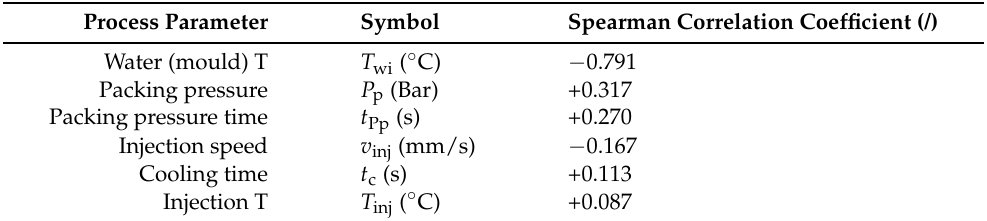
Table 5. Spearman correlation for the target parameter F mr . The greatest correlation is to the water (mould) temperature.